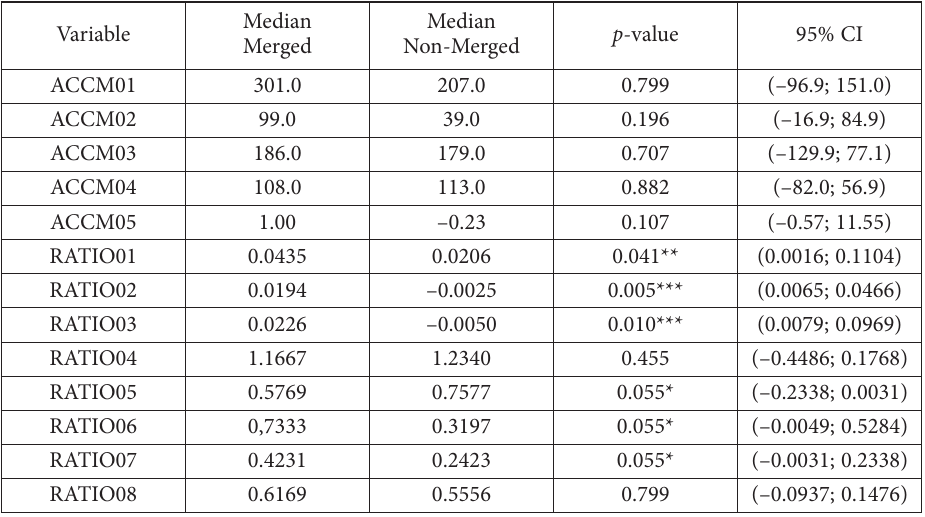
Table 4b. Comparison results (with median) of merged and non-merged firms (sample and control